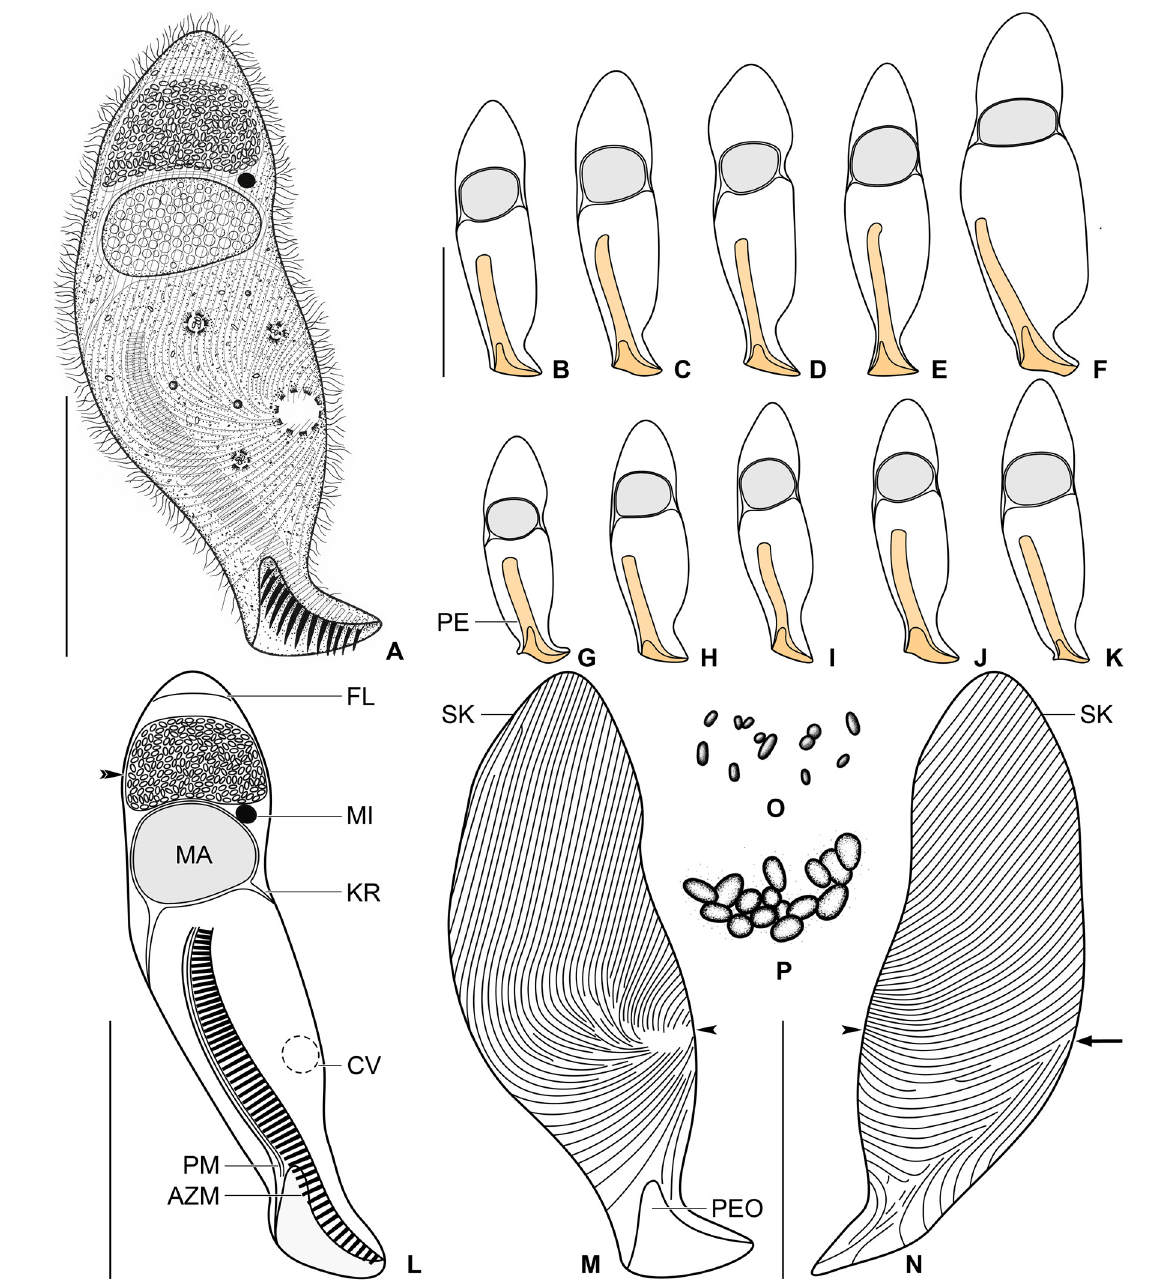
Fig. 1. Clevelandella constricta (Kidder, 1937). Vietnamese specimens isolated from Panesthia angustipennis cognata Bey-Bienko, 1969 from life (A) and after protargol impregnation (B–N). A . Ventral view of a representative specimen, length 120 μm. B–K . Variability of body shape and size as well as of the nuclear (shaded grey) and oral (shaded yellow) apparatus. L . Semi-schematic diagram, showing the general body organization. Black double arrowhead marks densely packed, oval, refractile bodies (probably paraglycogen platelets). M–N . Ciliary pattern of ventral and dorsal sides. Arrow marks the right suture, black arrowheads indicate the position of the ciliary whorl (posterior suture). O . Prokaryotes freely scattered throughout the cytoplasm posterior to the macronucleus. P . Detail of oval, refractile bodies (probably paraglycogen platelets) anterior to the macronucleus. Scale bars = 50